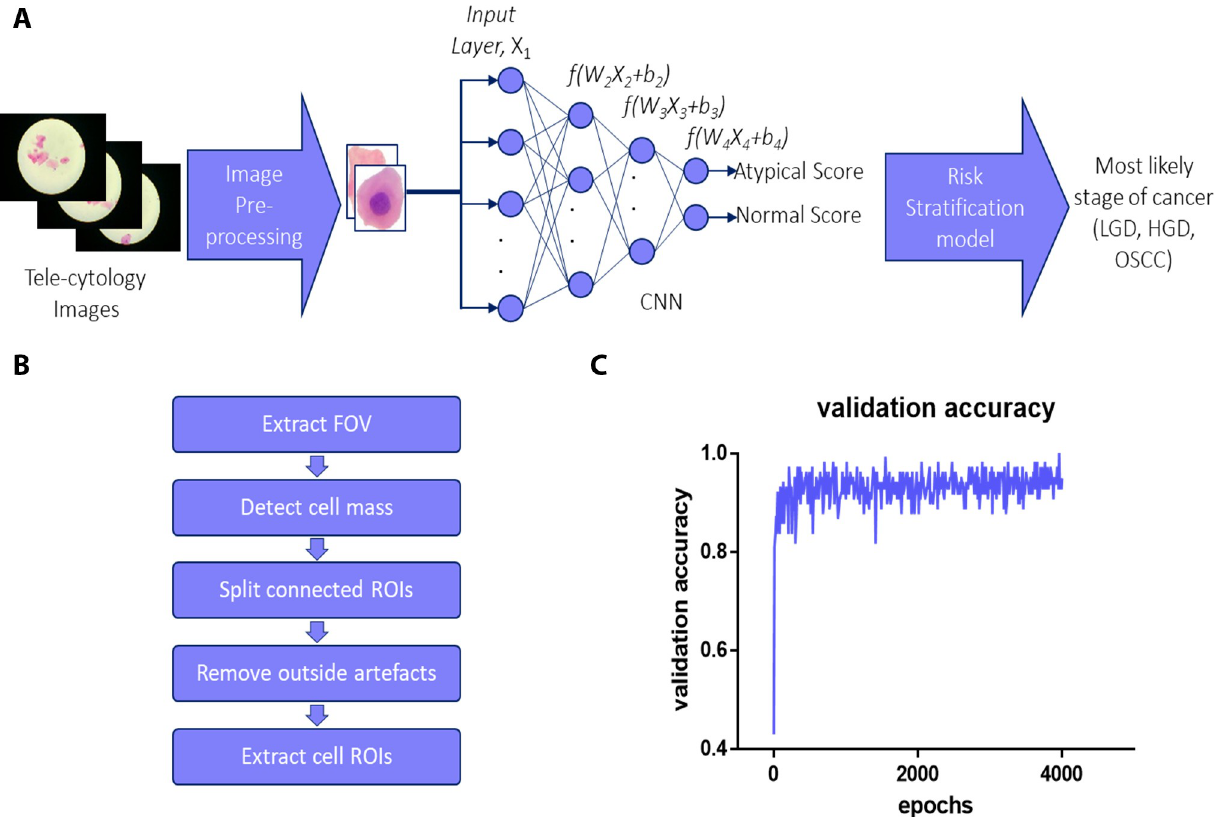
Fig 2. Workflow of image processing and ANN. Complete workflow (a) diagram of the automated diagnosis system; The cells are extracted from the tele-cytology images and are fed into a neural network and the values from all the cells in a patient are aggregated and used for developing risk stratification model. Image pre-processing algorithm (b) consisting of Field of View (FOV) extraction from the tele-cytology images, detection of contrasting cellular mass from the background, detachment of connected Region of Interests (ROIs), removing the artefacts outside the ROIs, and extracting cell ROIs. The graph represents validation accuracy during training (epochs = 4,000) of the ANN (c).